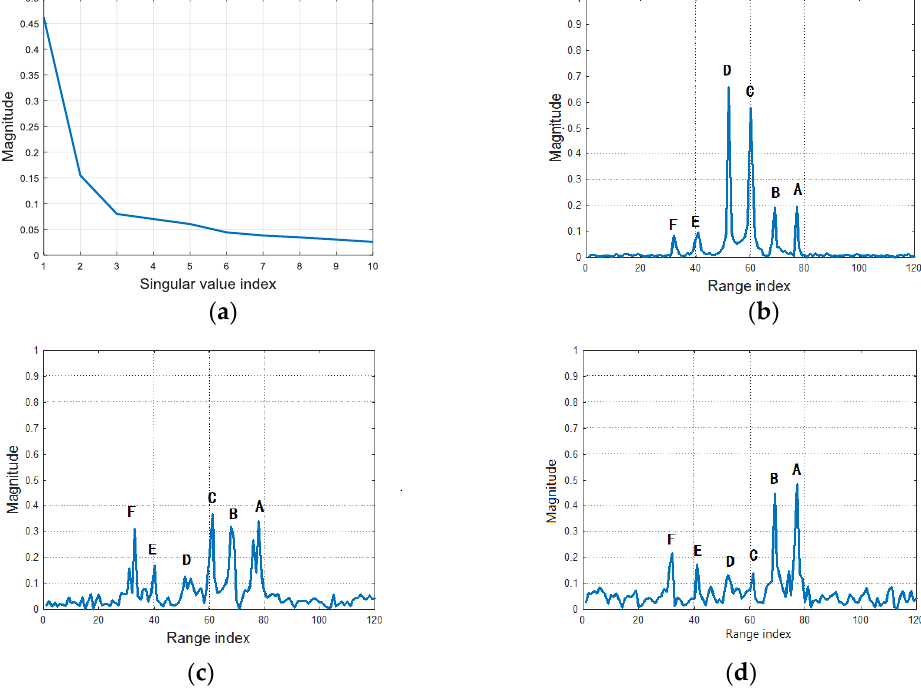
Figure 6. SVs and dominant RSVs of the HRRP sequence. ( a ) Singular values of HRRPs; ( b ) RSV corresponding to the 1st singular value; ( c ) RSV corresponding to the 2nd singular value; ( d ) RSV corresponding to the 3rd singular value. The scatterer extraction results on the largest RSV by ANM, OMP and BP are illustrated in Figure 7, where ANM is more accurate on the estimations of scatterer location and intensity than OMP and BP.